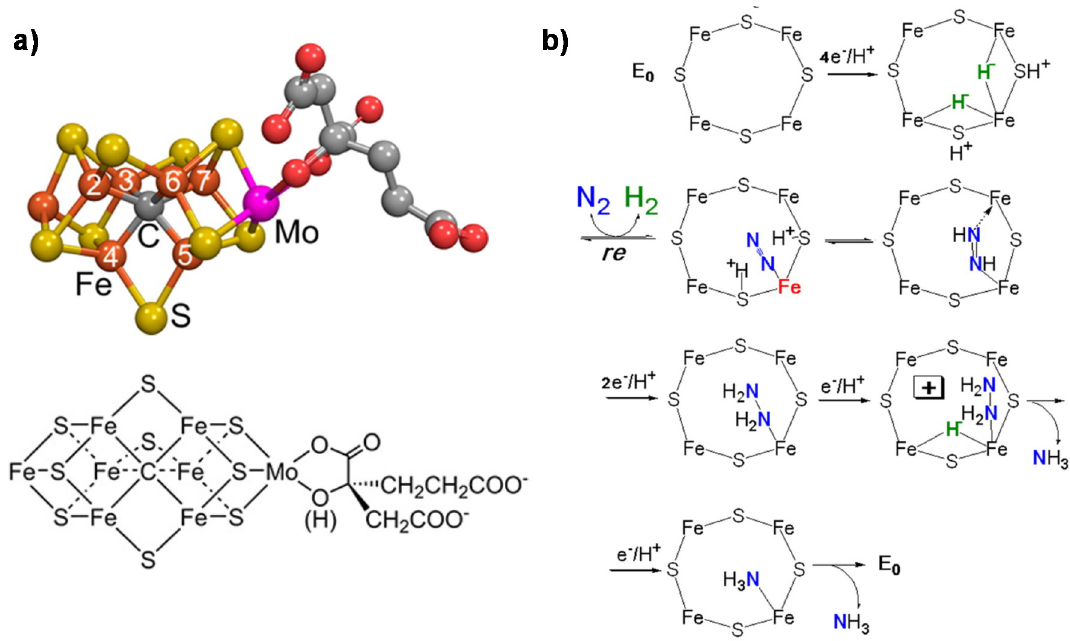
Figure 1. ( a ) FeMo cofactor (Fe in orange, Mo in magenta, S in yellow, C in gray and O in red); ( b ) mechanism (key elements) of N 2 fixation on FeMo-co. Adapted from [27]. Not subject to US copyright.